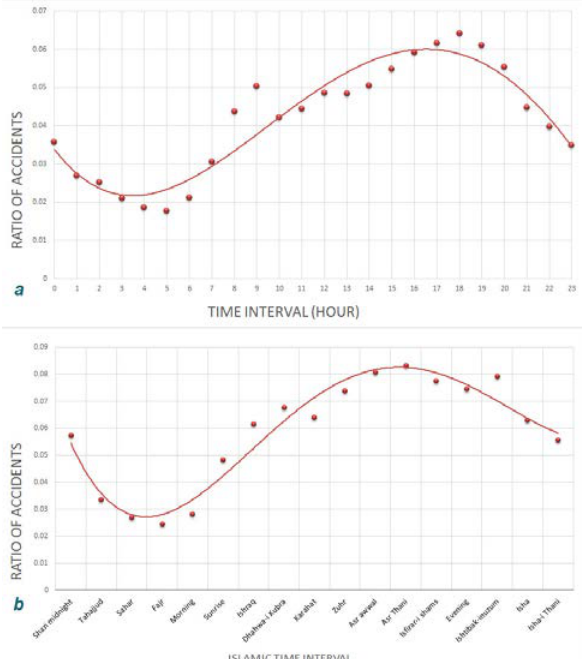
Figure 5. The percentage of accidents, (a) local time; (b) Islamic time However in this graph the number of accidents is still strongly affected by the volume of traffic. Therefore we normalized the number of accidents by the Hourly Annual Average Daily Traffic data, and the ratio of traffic accidents per minute normalized with the hourly volume of vehicles is obtained (Fig. 6).